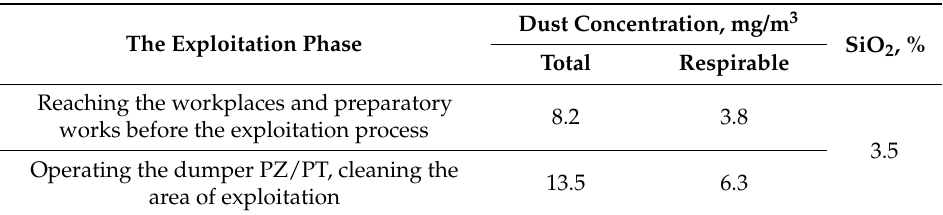
Table 12. The measurement results for the dust levels for selected activities, in the working position a miner operating the dumper PZ/PT.